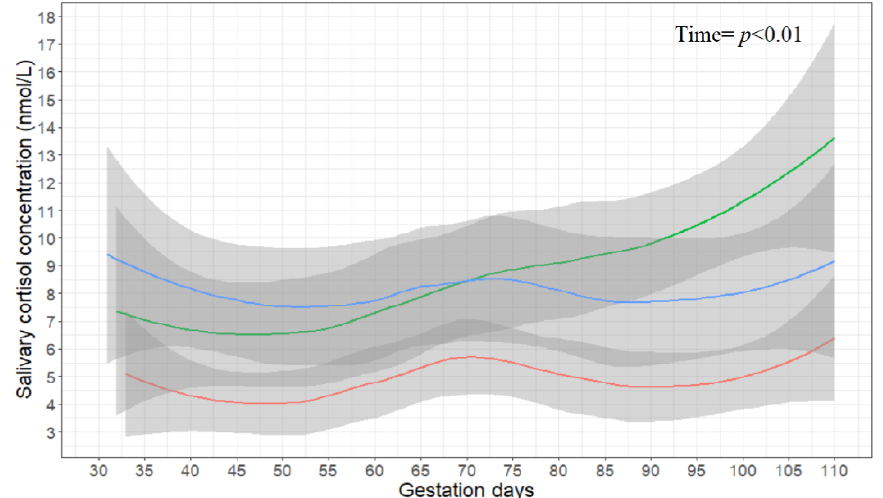
Figure 2. Salivary cortisol concentrations (nmol/L) during gestation in the three feed systems with the 95% confidence interval marked in grey for the free-access feeding stalls (Stall, red), floor feeding (Floor, green), and electronic sow feeding (ESF, blue).